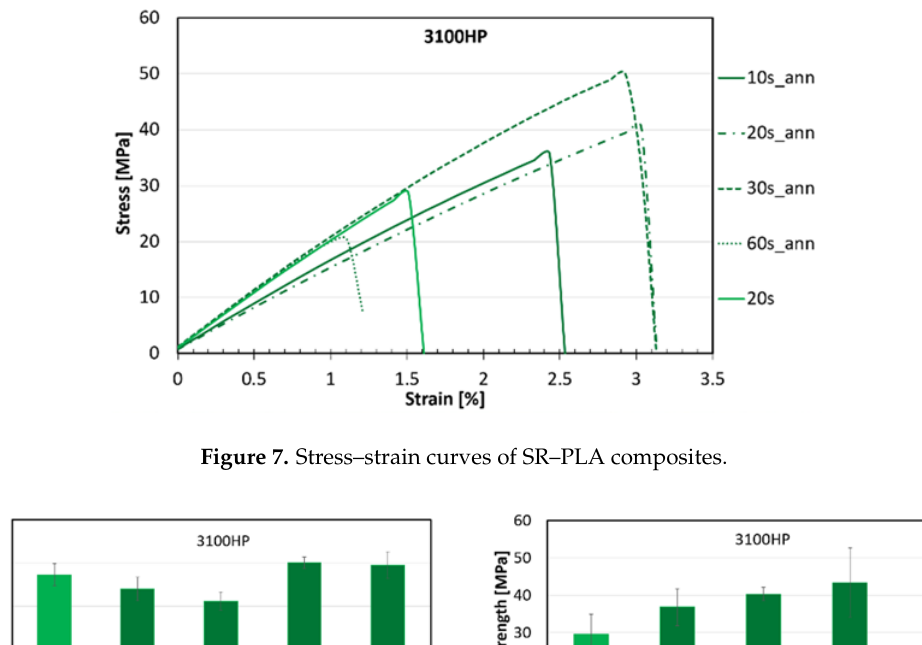
Figure 9. SEM images of self ‐ reinforcement (SR)–PLA composites made from non ‐ annealed ( a ) and annealed ( b ) fibres with 0.5% D ‐ lactide content (3100HP). Magnification: 300×.